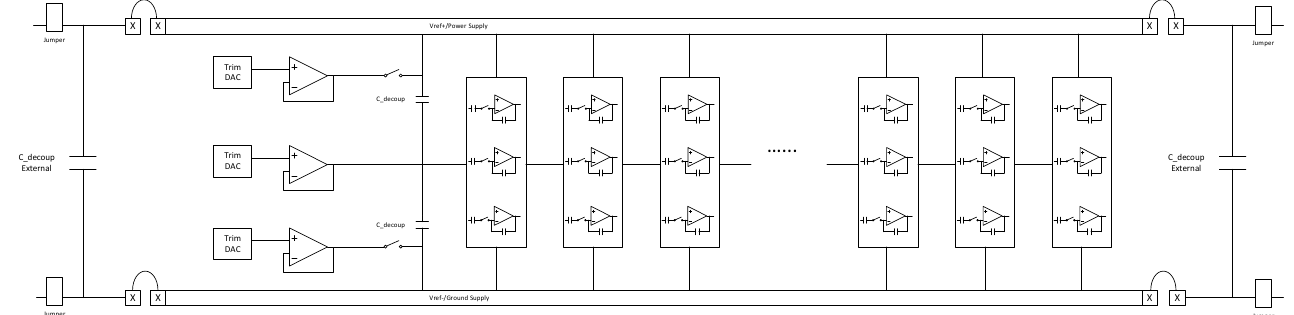
Figure 6. PCB board with pin-headers ready for external references generation and usage through the external connection with jumpers.